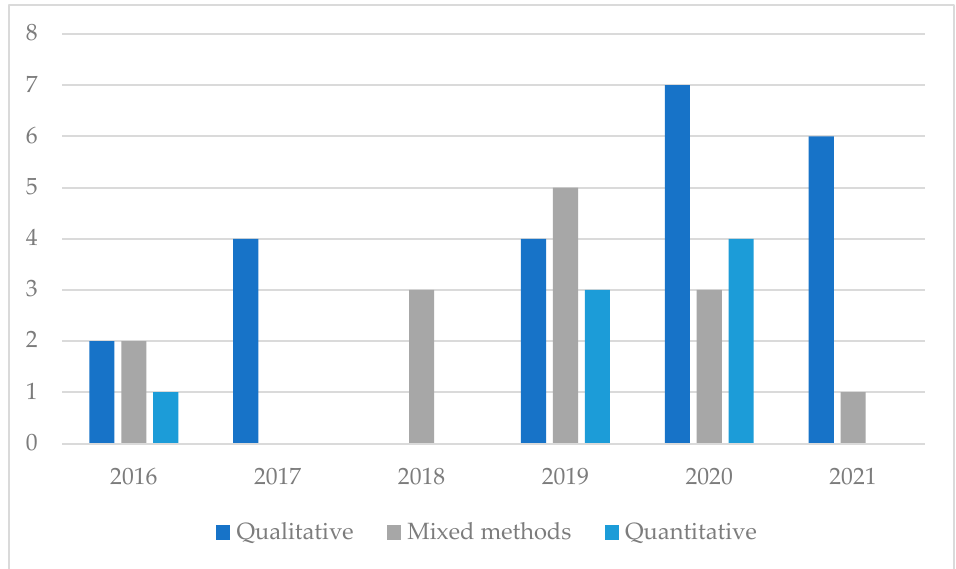
Figure 5. Research method by year of publication.